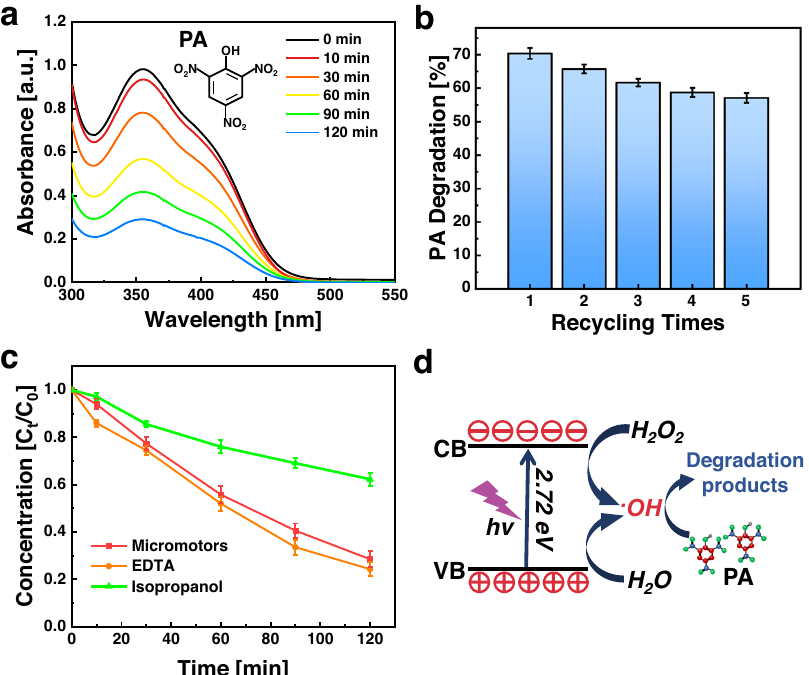
Fig. 3 Photocatalytic degradation of PA by WO 3 micromotors. a UV-Vis spectra of PA after photocatalytic degradation by WO 3 micromotors exposed to UV-light irradiation in 1% H 2 O 2 ; b Reusability assessment of WO 3 micromotors under 5 successive cycles of PA degradation; c Radical scavenger experiments conducted by employing EDTA and isopropanol; d Proposed WO 3 photodegradation mechanism. Error bars represent the standard deviation, n = 3 independent replicates.